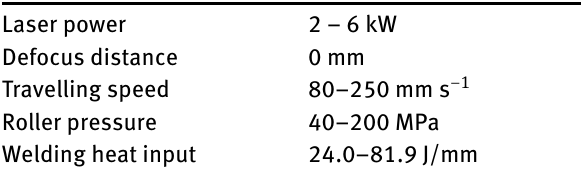
Table 2: Range of welding parameters Laser power 2 – 6 kW Defocus distance 0 mm Travelling speed 80–250 mm s −1 Roller pressure 40–200 MPa Welding heat input